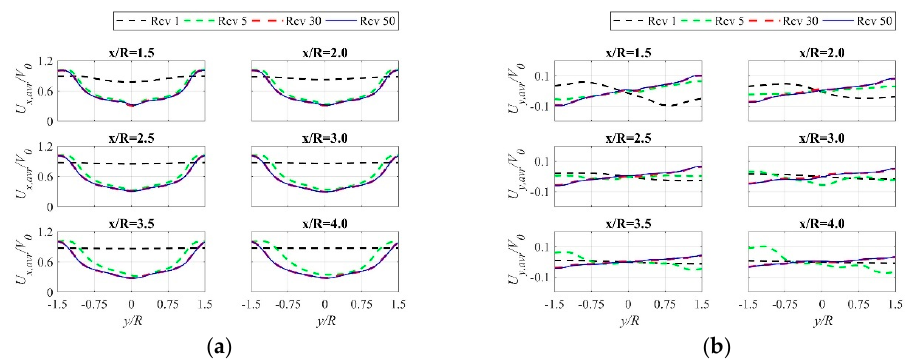
Figure 14. Velocity profiles for example rotor rotations: ( a ) U x velocity component; ( b ) U y velocity component.